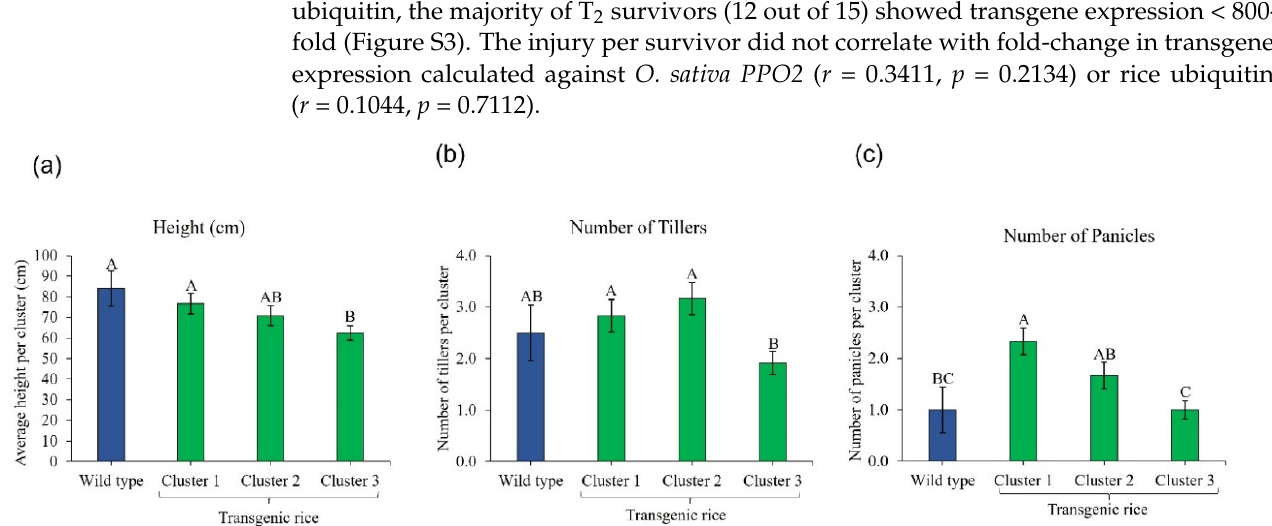
Figure 2. Response of transgenic rice plants to soil-applied fomesafen (390 g ha − 1 ). ( a ) The response of wild type and T 2 rice plants 3 weeks after soil treatment. The photos show one run of the experi- ment; (A) WT nontreated, (B) WT treated, (C) T 2 nontreated, and (D) T2 treated. ( b ) Wild-type and T 2 germination reduction (%) calculated 3 weeks after soil-applied fomesafen treatment. Means were derived from a combined analysis of two runs since plant response to treatments did not vary across runs. Lowercase letters indicates significant difference ( p < 0.05).